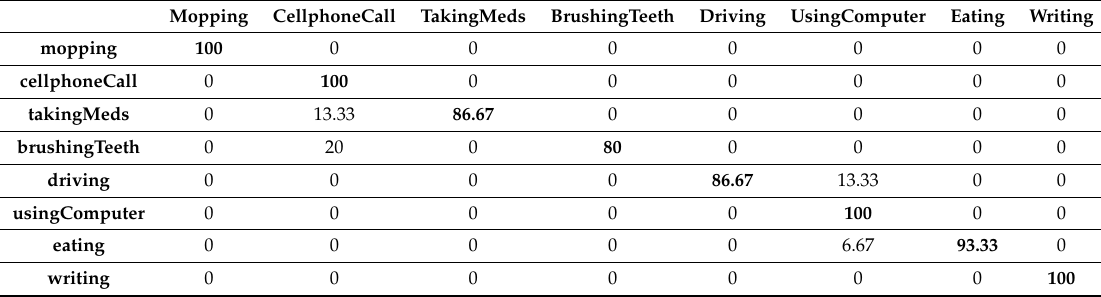
Table 1. Confusion matrix for Analysis 1 . The value in each cell represents that the percentage that the row’s activity observation is matched to the column’s activity